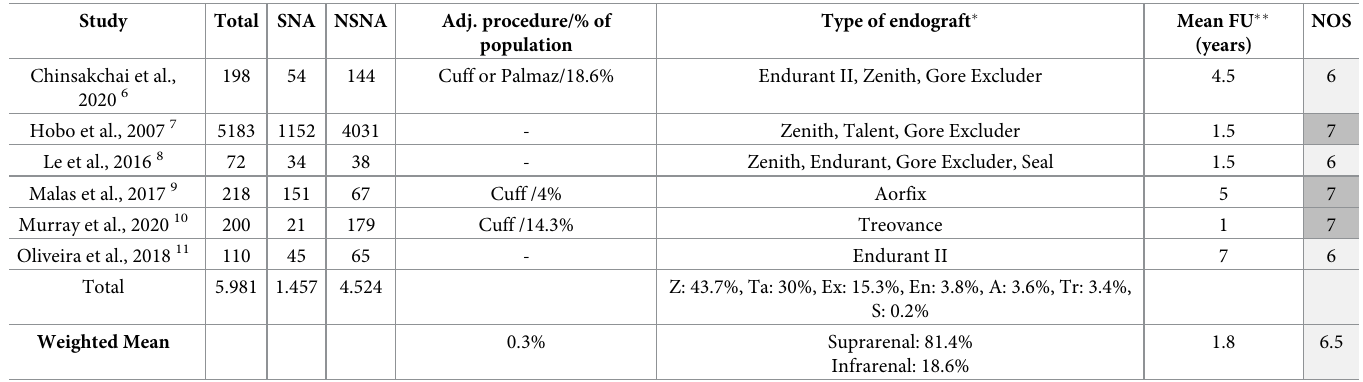
Table 1. Study characteristics.